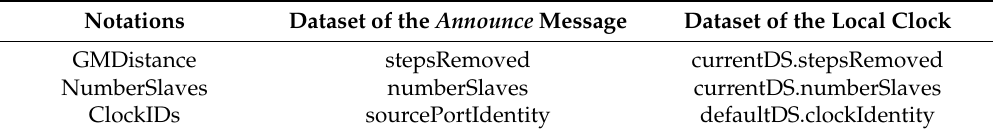
Figure 6. The dataset comparison algorithm of the BSHSM algorithm. Table 2. Information sources for dataset comparison in the BSHSM algorithm.